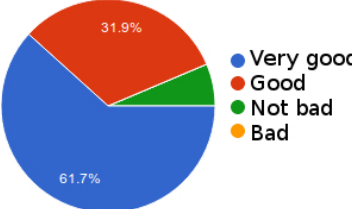
Figure 9. General assessment of PyBoKids by